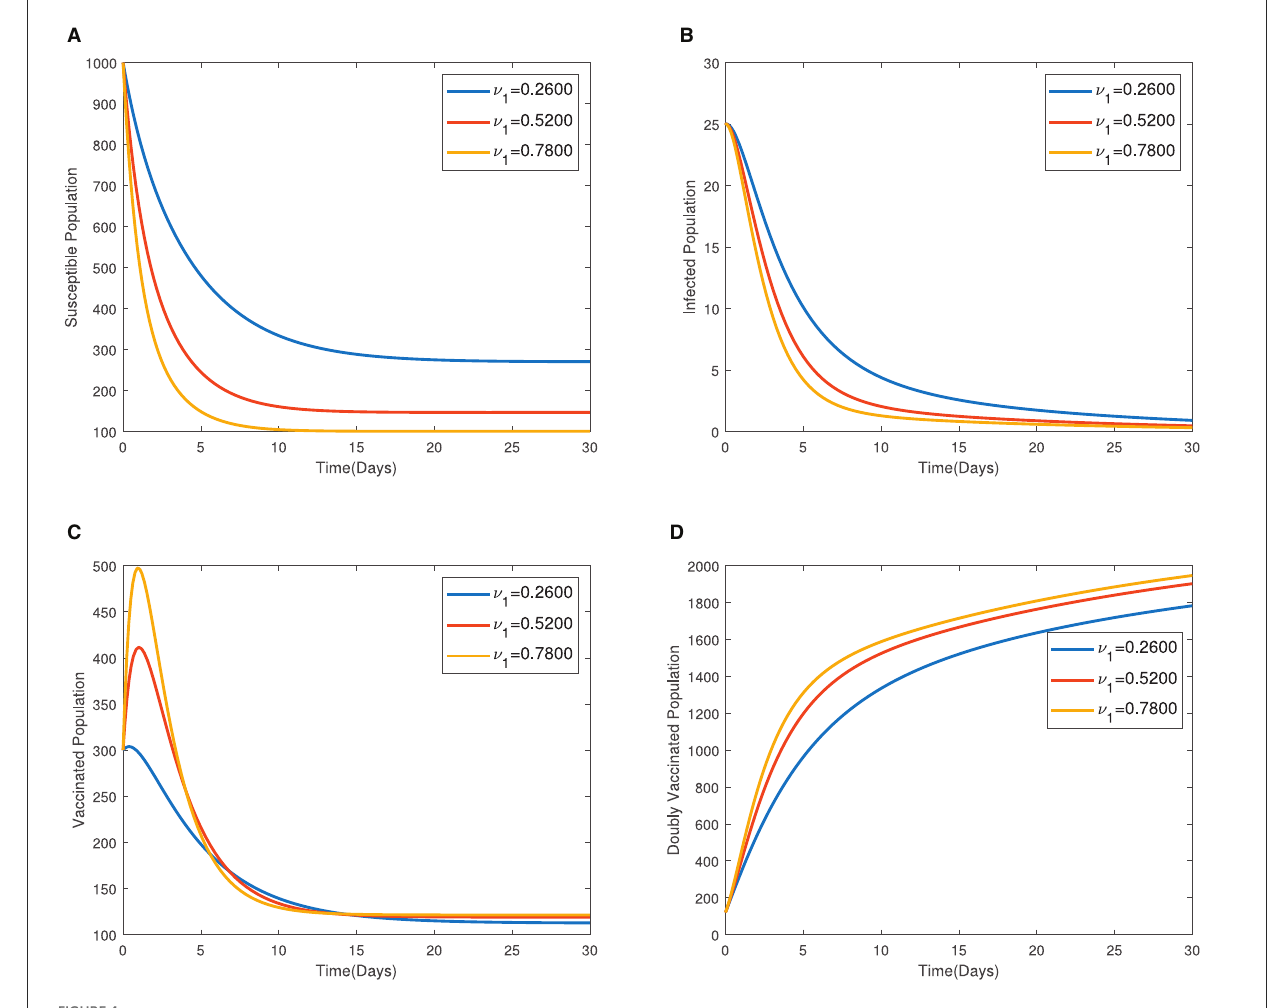
FIGURE4 (A–D) Time series plots of model variables showing the impact of varying the rate of administration of the first dose of vaccine.